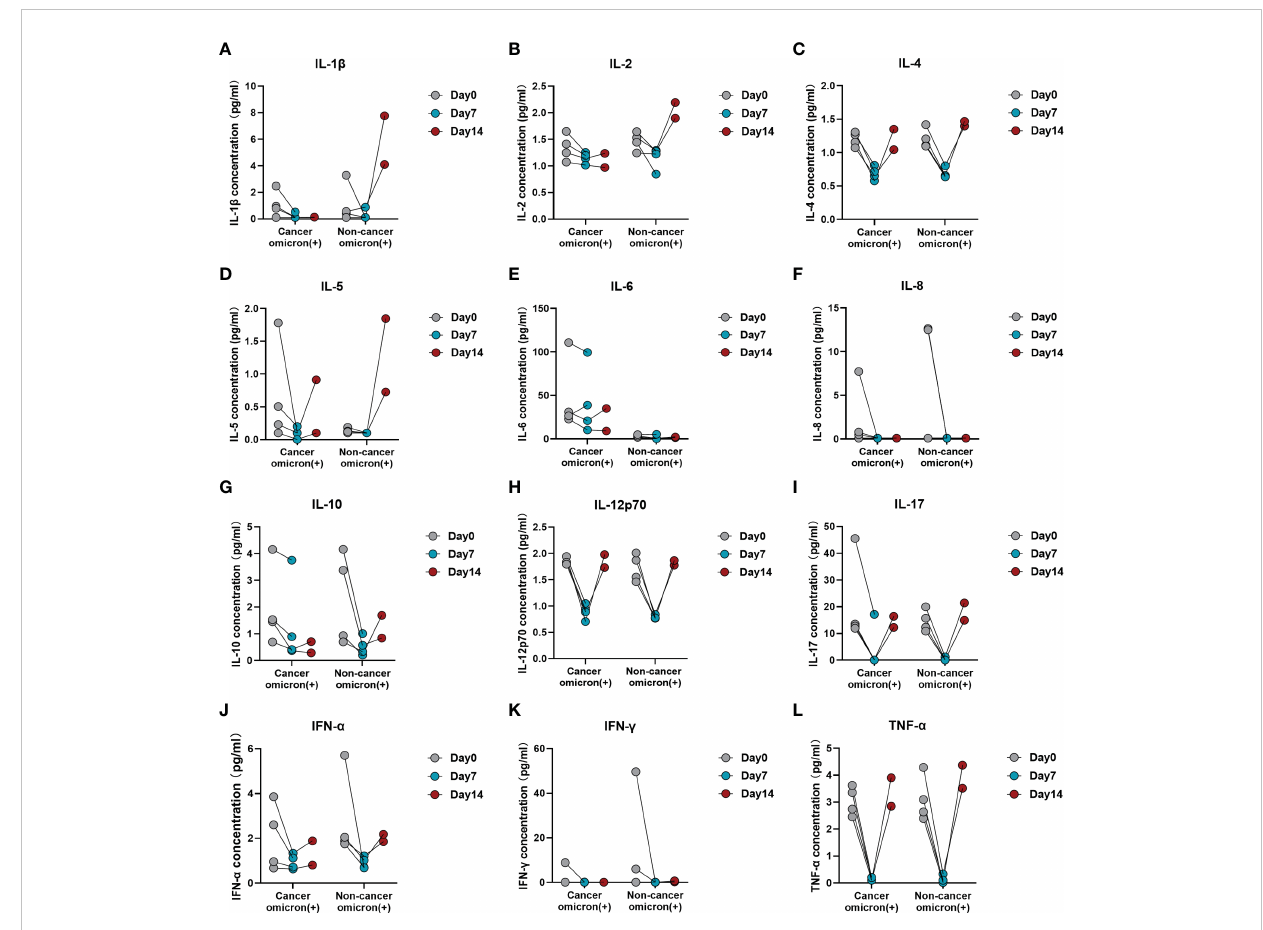
FIGURE 7 Time-course variations of cytokines in Omicron-infected patients with or without cancer disease. Group 1 were cancer patients with Omicron infection, and Group 3 were non-cancer patients with Omicron infection. The comparison of results from three timepoint detections of IL-1 b (A) , IL-2 (B) , IL-4 (C) , IL-5 (D) , IL-6 (E) , IL-8 (F) , IL-10 (G) , IL-12p70 (H) , IL-17 (I) , IFN- a (J) , IFN- g (K) , and TNF- a (L) between Groups 1 and 2 during clinical